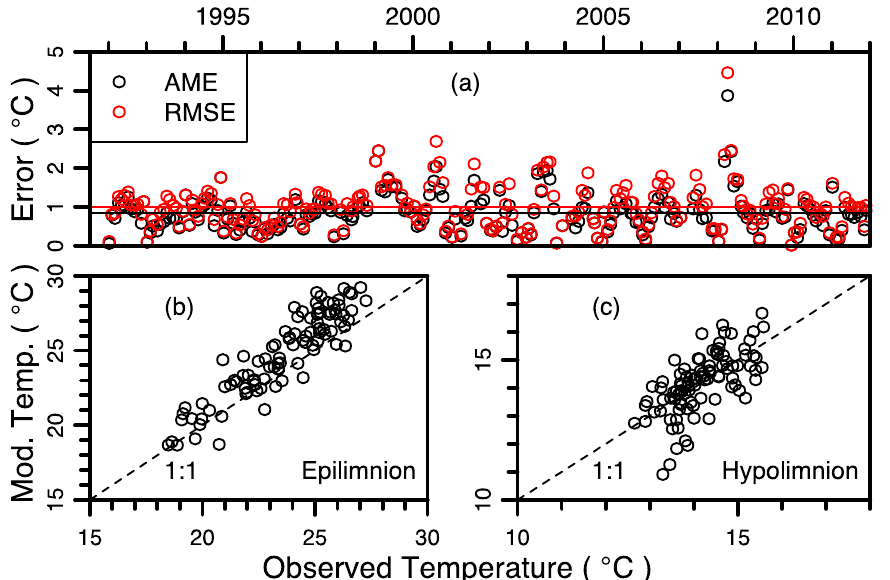
Figure 3. ( a) Time series of AME and RMSE of simulated temperature profiles on 226 days having observed profiles (1992 to 2011) with lines showing means at 0.84 °C for AME and 1.0 °C for RMSE. ( b ) Modeled ( T MOD , reference run with no change) versus observed ( T OBS ) epilimnetic temperature, which gives an Adj. R 2 of 0.83 and p < 0.001 ( T MOD = − 2.13 + 1.14 × T OBS ). ( c ) Modeled (reference run with no change) versus observed hypolimnetic temperature, which gives an Adj. R 2 of 0.42 and p < 0.001 ( T MOD = − 0.08 + 1.01 × T OBS ).